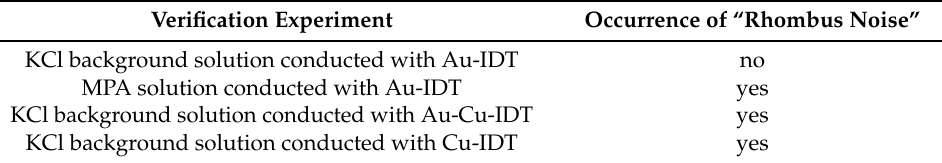
Table 1. Experimental verification concerning the occurrence of the “rhombus noise”.